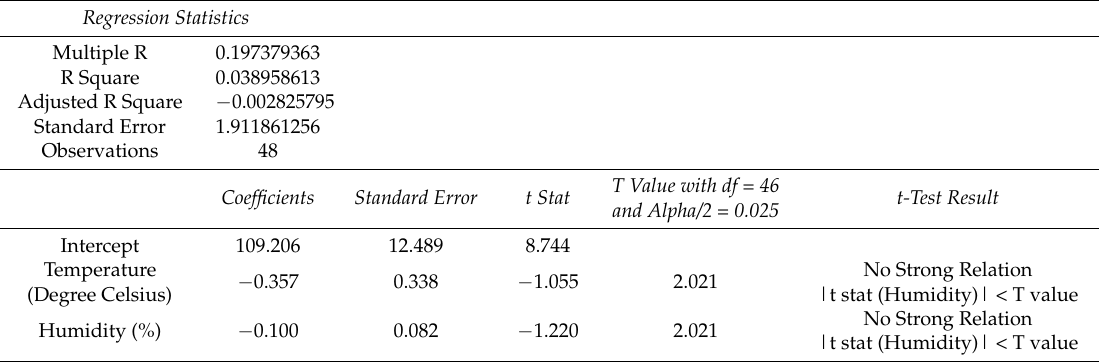
Table 4. Regression analysis output and t-test approach on the data for month of